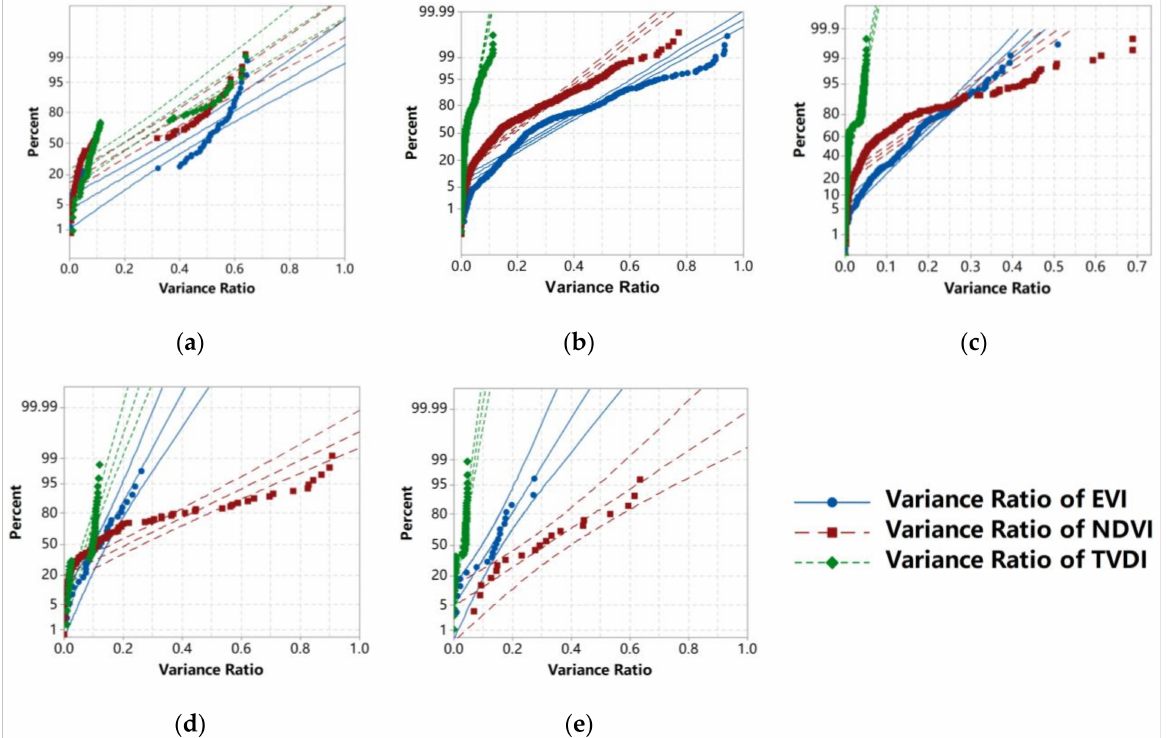
Figure 4. Probability plot of variance ratio of NDVI, EVI, and TVDI in sub-regions of China: ( a ) NW; ( b ) SW; ( c ) HJ; ( d ) AP; and ( e )